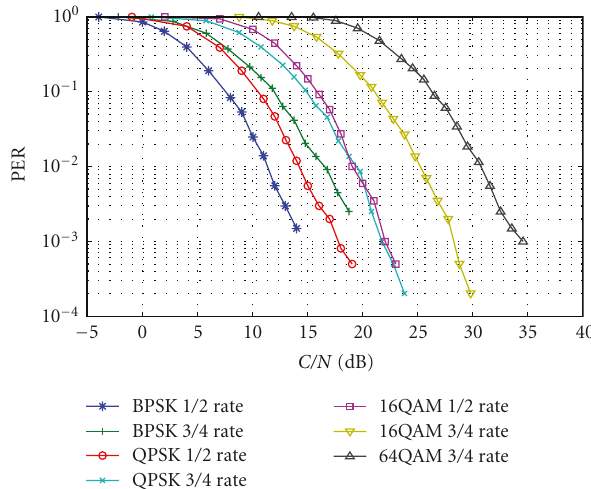
Figure 1: IEEE 802.11a/g PER performance, ETSI, BRAN Channel A [14], 825byte